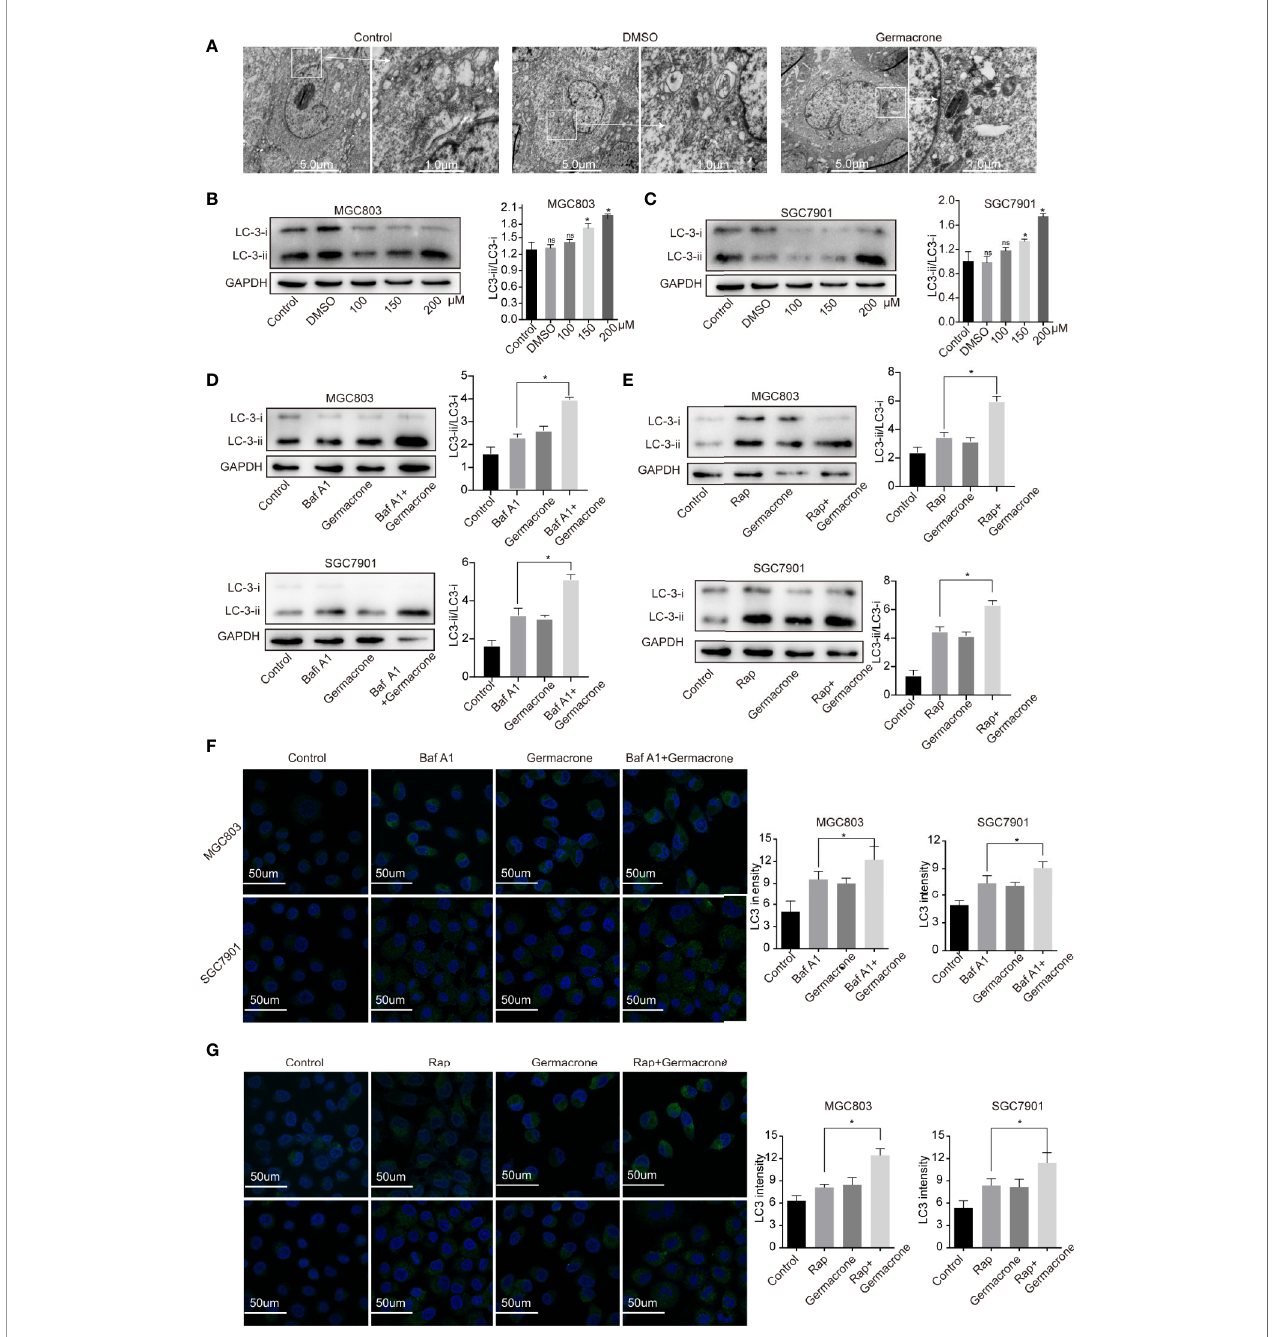
FIGURE 4 | Germacrone promoted the formation of autophagosomes in gastric cancer cells. (A) Scanning electron microscopy was used to visualize autophagosome accumulation. (B, C) Changes in the protein expression levels of LC3I, LC3II were detected by western blot. (D) Changes in the protein expression levels of LC3I, LC3II in SGC7901 and MGC803 cells after 24 h of treatment with Baf A1. (E) Changes in the protein expression levels of LC3I, LC3II in SGC7901, and MGC803 cells after 24 h of treatment with Rap. (F) Immuno fl uorescence was used to detect the protein expression levels of LC3 after exposure to Baf A1 and germacrone (150 µM) for 24 h. (G) Immuno fl uorescence was used to detect the protein expression levels of LC3 after exposure to Rap and germacrone (150 µM) for 24 h. Data are the means ± SD of three experiments. * P < 0.05; ns, not signi fi